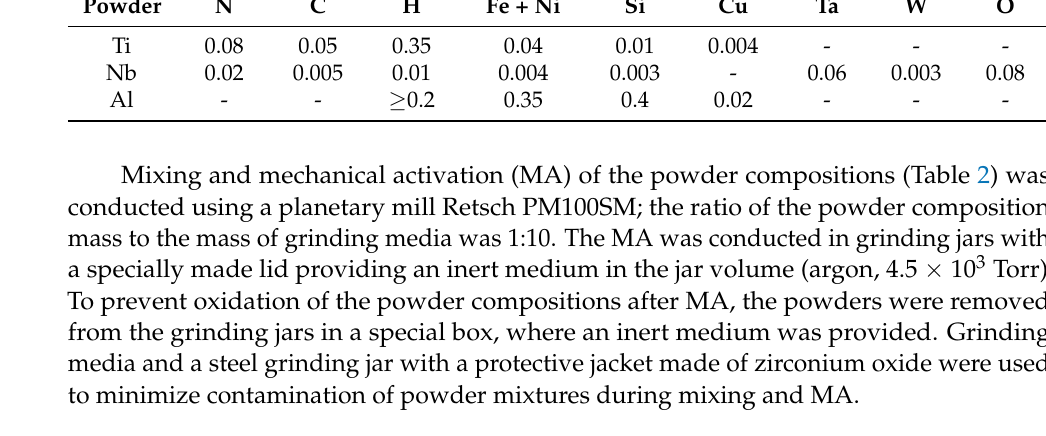
Table 2. MA parameters.